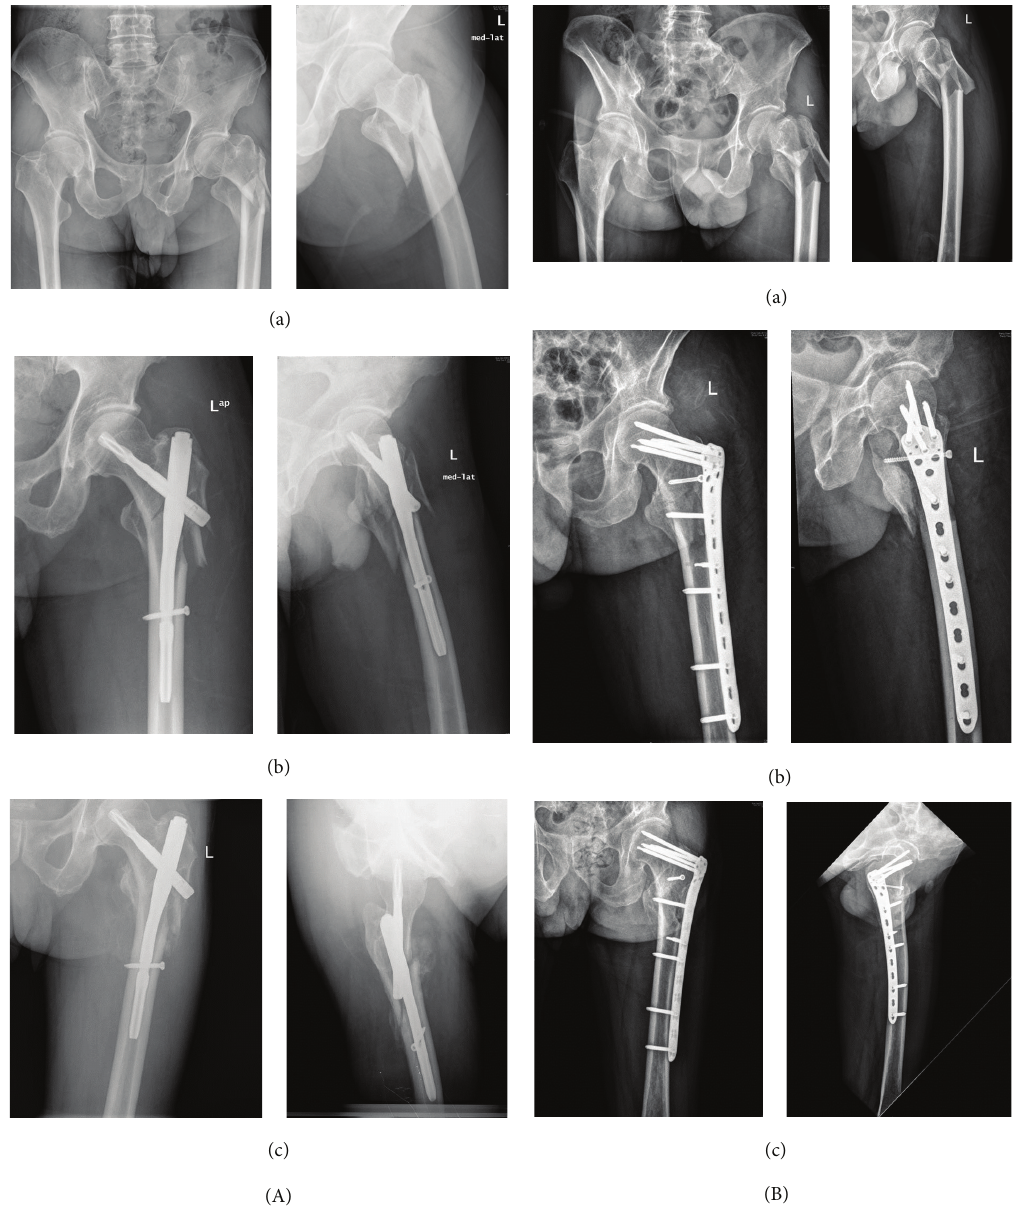
Figure 3: Patients with 31 A3 fractures. (A) PFNA (A(a)) Preoperative AP view and lateral view. (A(b)) Immediate postoperative AP view and lateral view. (A(c)) Six weeks postoperatively. Callus formation can be seen in both AP view and oblique view. (B) Reverse LISS (B(a)) Preoperative AP view and lateral view. (B(b)) Immediate postoperative AP view and lateral view. (B(c)) Six months postoperatively. Reverse LISS successfully maintained the reduction till bony